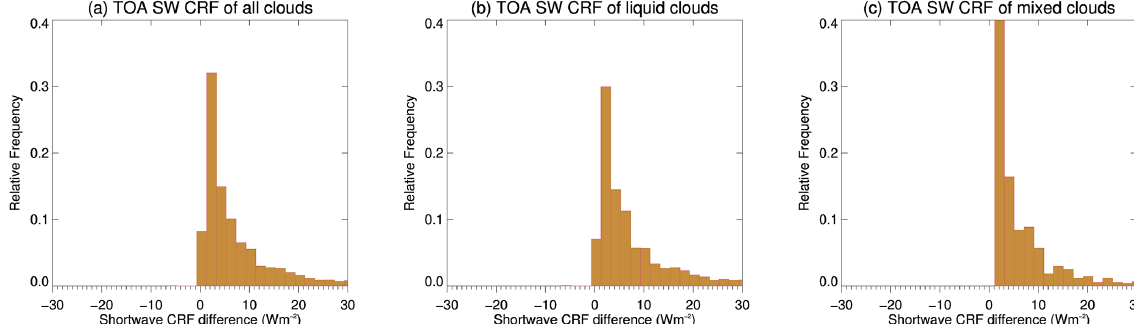
Figure 16. Histogram of shortwave cloud radiative forcing at the TOA between using clouds from surface observations and clouds identified by combined CloudSat and CALIPSO for (a) all clouds, (b) liquid clouds, and (c) mixed-phase clouds during the SHEBA